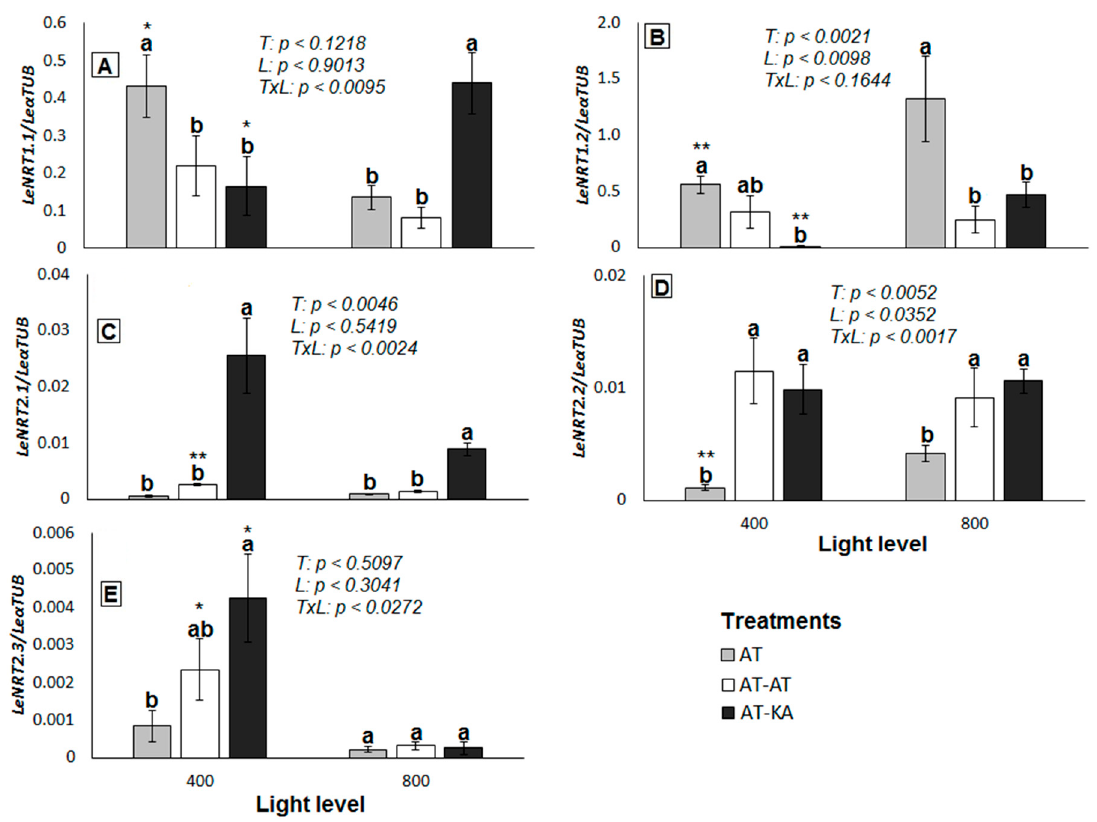
Figure 3. Relative expression of LeNRT1.1 ( A ), LeNRT1.2 ( B ), LeNRT2.1 ( C ), LeNRT2.2 ( D ), and LeNRT2.3 ( E ) in roots of plants from each grafting combination exposed to medium (400 µmol PAR m − 2 s − 1 ) or high light level (800 µmol PAR m − 2 s − 1 ). The reference gene corresponds to α -tubulin. Bars represent mean ± SE of four replicates. p -Values for treatment ( T ), light ( L ) and the interaction ( TxL ) effects are included in each case. Different letters denote significant differences ( p < 0.05) among treatments within each light level. Asterisks indicate the significance level ( * : p < 0.05 ; ** : p < 0.01) for the differences in the same treatment across light levels. AT: Non-grafted treatment; AT-AT: Homograft; and, AT-KA: Graft treatment. Table 2. Apparent V max and K m of net nitrate uptake for each treatment under medium (400 µ mol biological independent replicates ± SE. AT: Non-grafted treatment; AT-AT: Homograft; and, AT-KA: Graft